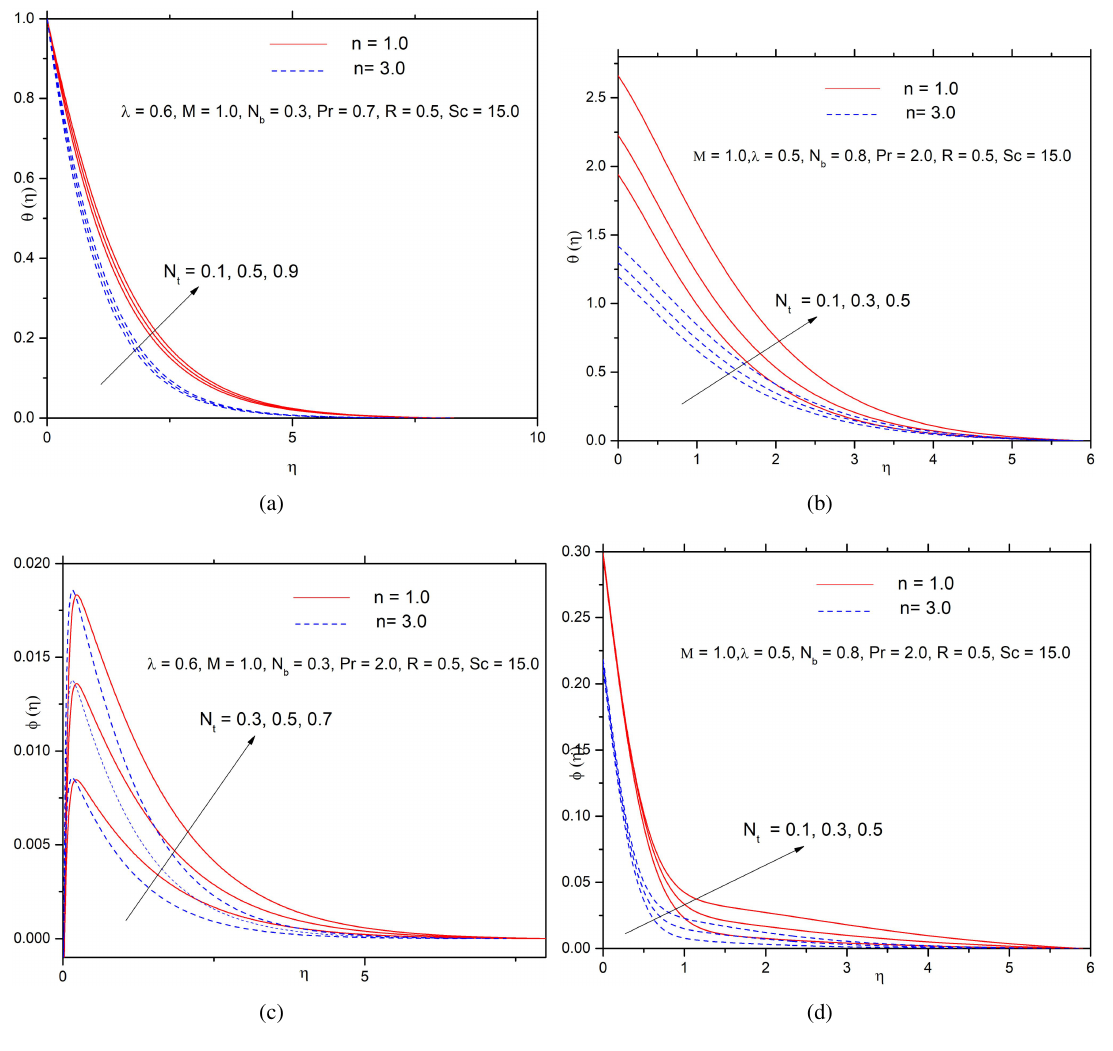
Fig. 5 Influences of thermophoresis parameter N t on temperature θ ( η ) for (a) CWT and (b) PHF and on ϕ ( η ) , nanoparticle volume fraction for (c) ZMF and (d)